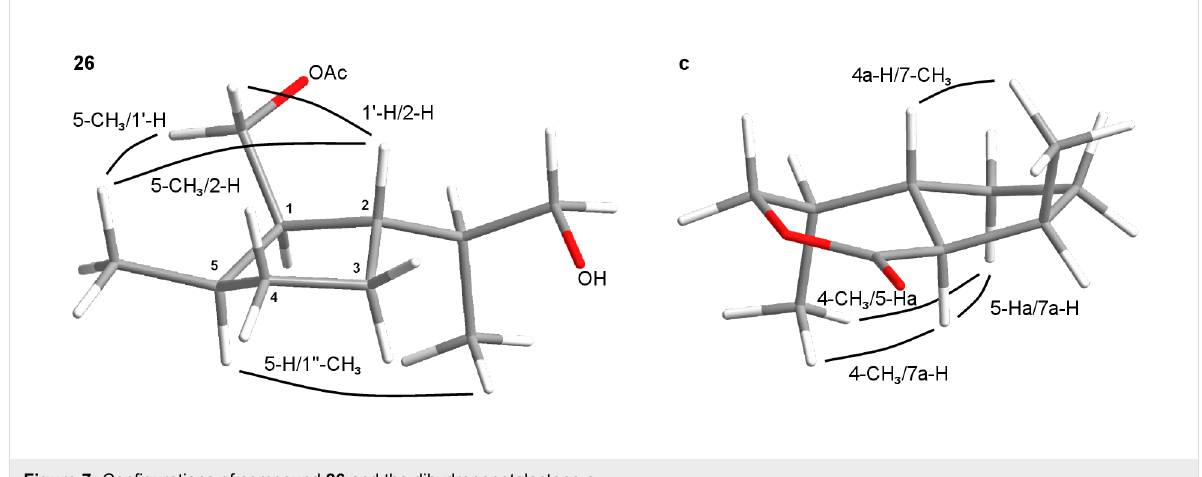
Figure 7: Configurations of compound 26 and the dihydronepetalactone c